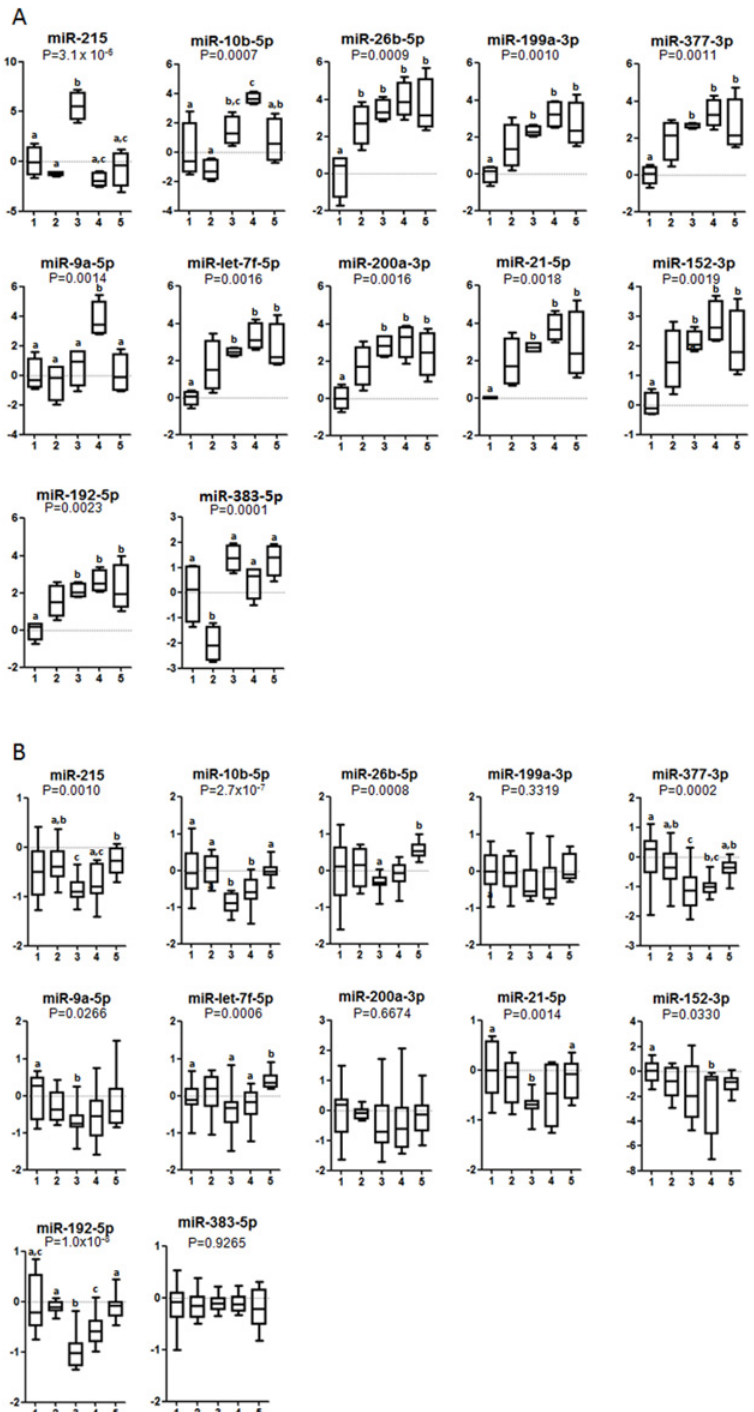
Fig 3. Expression levels of microRNAs in liver of 1 day old (A) and adult pups (B) according to their mother ’ s dietary treatment during the first 12 days of pregnancy. Data is expressed as fold change (mean ± SD) relative to SO diet group. SO diet, 1; OO diet, 2; FO diet, 3; LO diet, 4; PO diet, 5. Different letters in the same graph means statistical difference (P < 0.05) between dietary groups. Animals per group, in (A) n = 4. In (B): SO (n = 12), OO (n = 12), FO (n = 12), LO (n = 10) and PO (n =